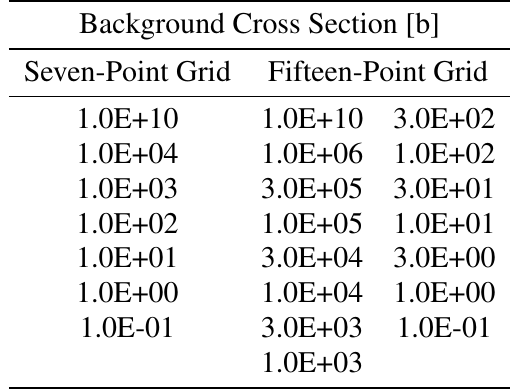
Table 1: Dilution grids used in this analysis. On the left, a naively chosen seven-point dilution grid. On the right, a fifteen-point dilution grid based on approximately equally